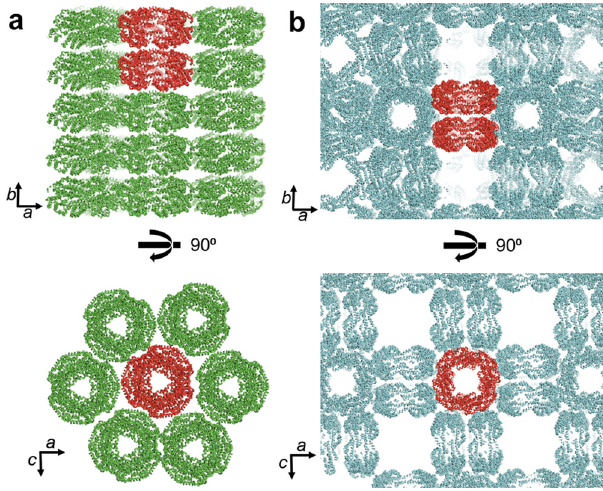
Fig. 2 Crystal packings of Tl CPC-6 and Tl CPC-8. Tl CPC-6 ( a ) and Tl CPC-8 ( b ) in crystals are shown as ribbon representations. Two representatives rod-like [( αβ ) 6 ] 2 and [( αβ ) 8 ] 2 structures are shown in